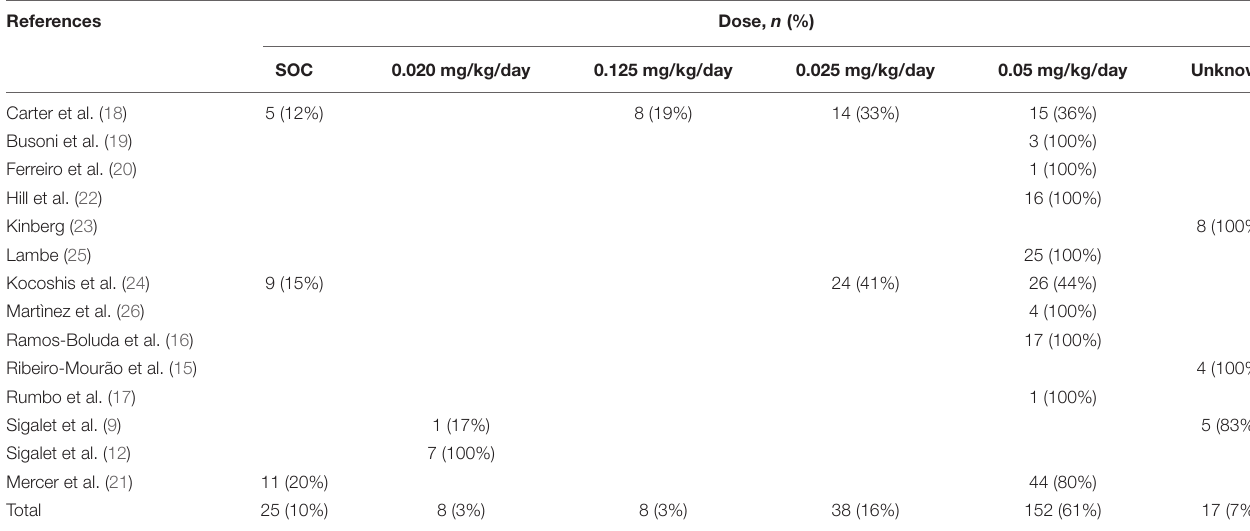
TABLE 4 | Characteristics of teduglutide